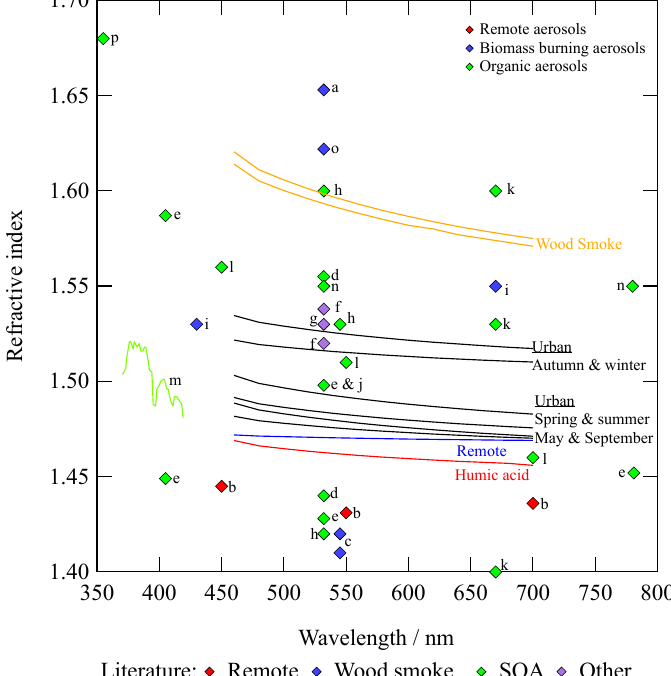
Figure 4. Refractive index dispersions for urban, remote, and woodsmoke atmospheric aerosol extracts and humic acid aerosol, compared to refractive index values from the literature. A sample of literature studies investigated aerosols from (1) remote locations (e.g. b: Virkkula et al., 2006); (2) biomass burning (e.g. a: Hoffer et al., 2006; c: Guyon et al., 2003; i: Yamasoe et al., 1998; n: Chakrabarty et al., 2010; and o: Dinar et al., 2008); and (3) organic aerosols (e.g. d: Kim and Paulson, 2013; e: Nakayama et al., 2013; h: Lambe et al., 2013; j: